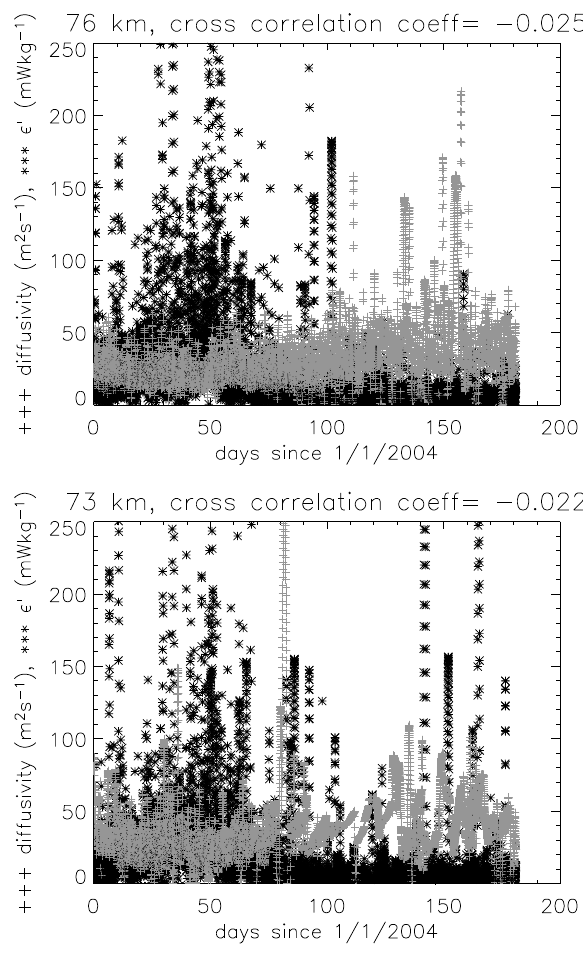
Fig. 2. Time series of estimates of neutral air turbulent energy dis- sipation rate ( ε ’) obtained by the Tromsø MF radar (black aster- isks) and the diffusion coefficient values found from meteor trail echo fading times (grey pluses). Upper panel: 76km; lower panel: